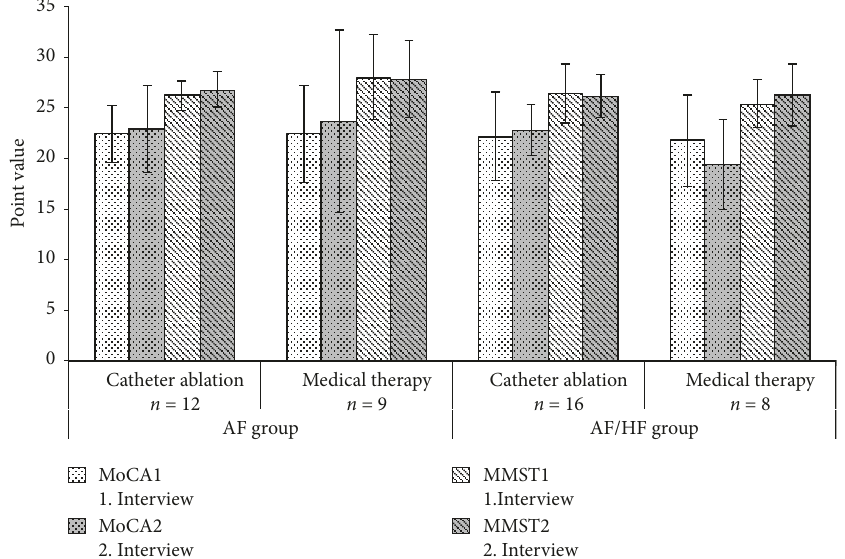
Figure 2: Mean results in MoCA and MMSE test with 6 months intertest interval. AF � atrial fibrillation, HF � heart failure, MoCA � Montreal Cognitive Assessment, and MMSE � Mini-Mental State